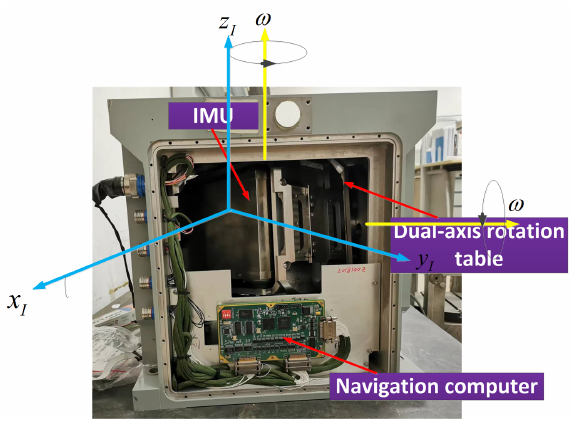
Figure 3. Dual-axis RINS.